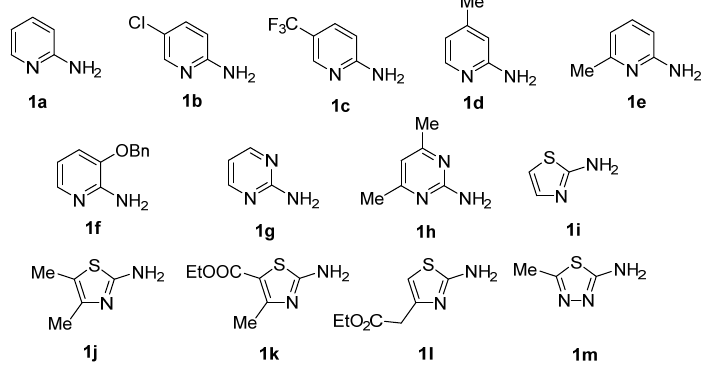
Figure 2. The diversity of 2-aminoazines and -azoles 1a–m that were employed in the GBB synthesis of 5- nitrofuran-tagged compounds that were investigated in this work. A unique substrate input ( 1a–m ) was employed in the preparation of each of the GBB products ( 4a–m ) by mixing equimolar amounts of 1 , 5-nitrofurancarboxaldehyde and an isocyanide ( c -HexNC or t -BuNC) in methanol in the presence of 20 mol% of p -toluenesul- fonic acid catalyst [39]. The reactions were complete within 24 h at room temperature. Following a brief aqueous workup, the target imidazo-fused GBB reaction products 4a–m were isolated chromatographically in moderate to excellent yield (Scheme 1). The yields of the GBB reaction products that were derived from 2-aminoazoles were markedly lower compared to their 2-azine-derived counterparts.